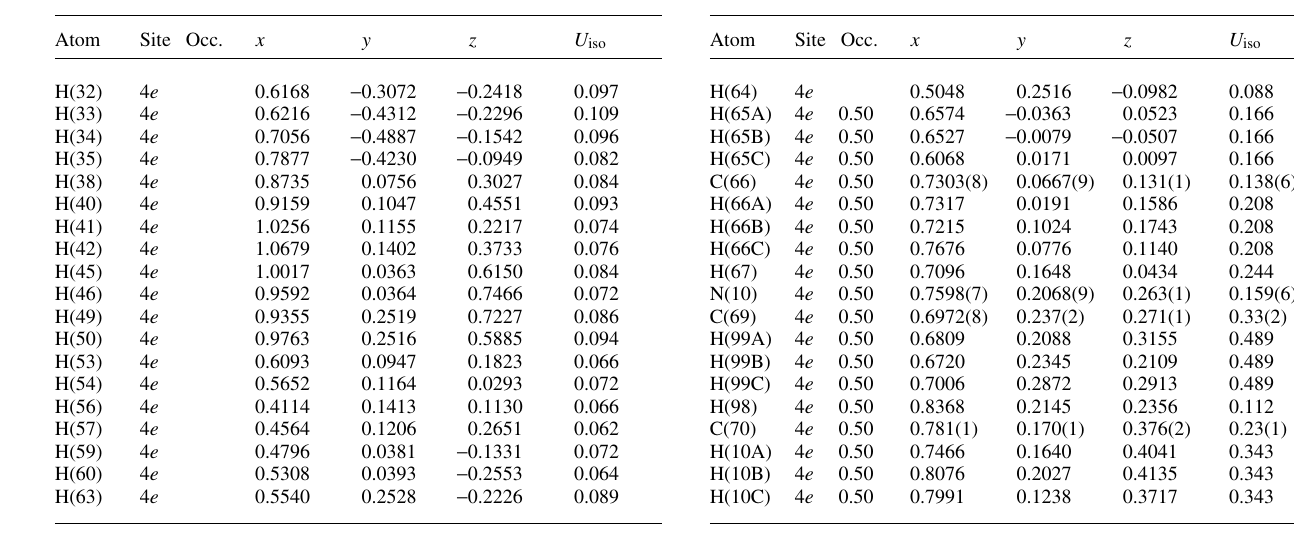
Table 3. Atomic coordinates and displacement parameters (in Å 2 ) . Atom Site